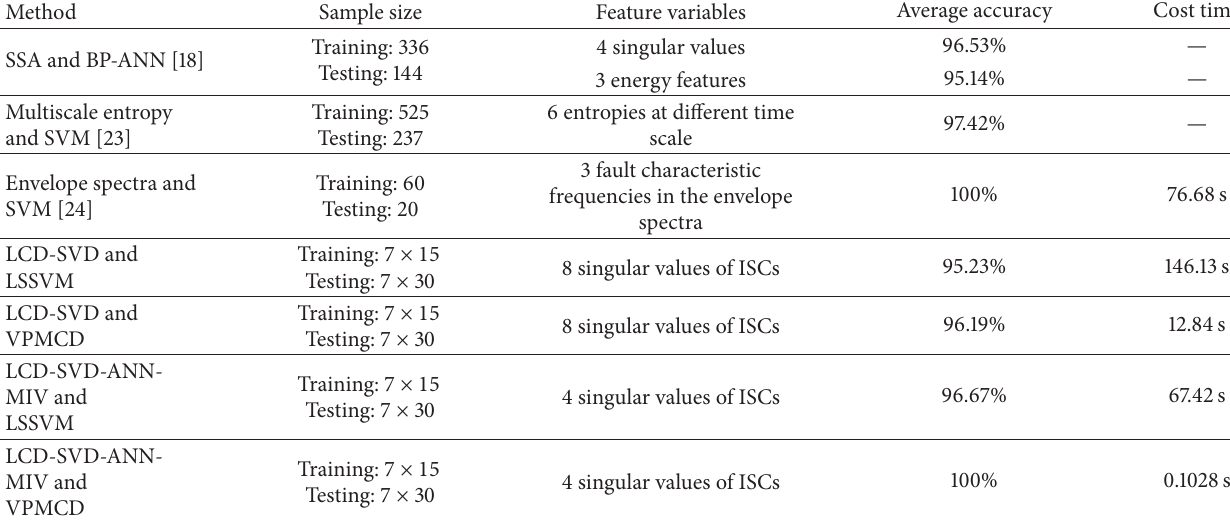
Table 8: Comparison between different diagnosis